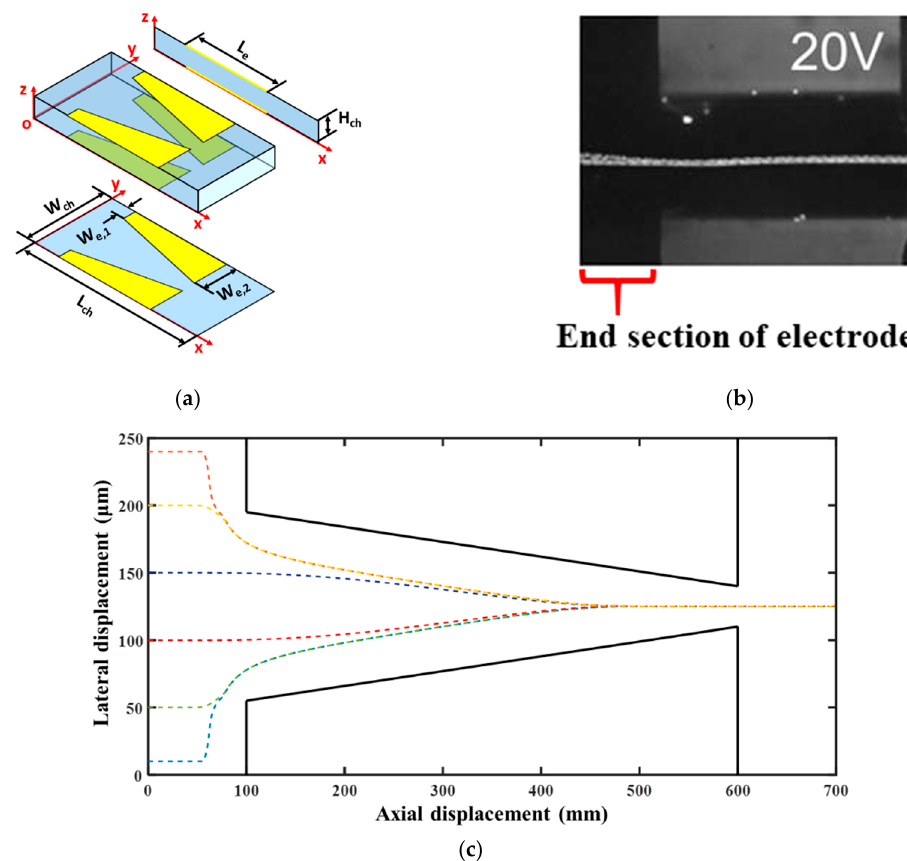
Figure 4. ( a ) Microfluidic device of Holmes et al. [9], ( b ) trajectories in the microfluidic device of Holmes et al. [9], and ( c ) trajectories based on the model ( r p = 6 μ m, W ch = 250 μ m, H ch = 40 μ m, L e = 500 μ m, L ch = 700 μ m, W e,1 = 55 μ m, W e,2 = 105 μ m). Figure 4b is reproduced with permission from Elsevier,